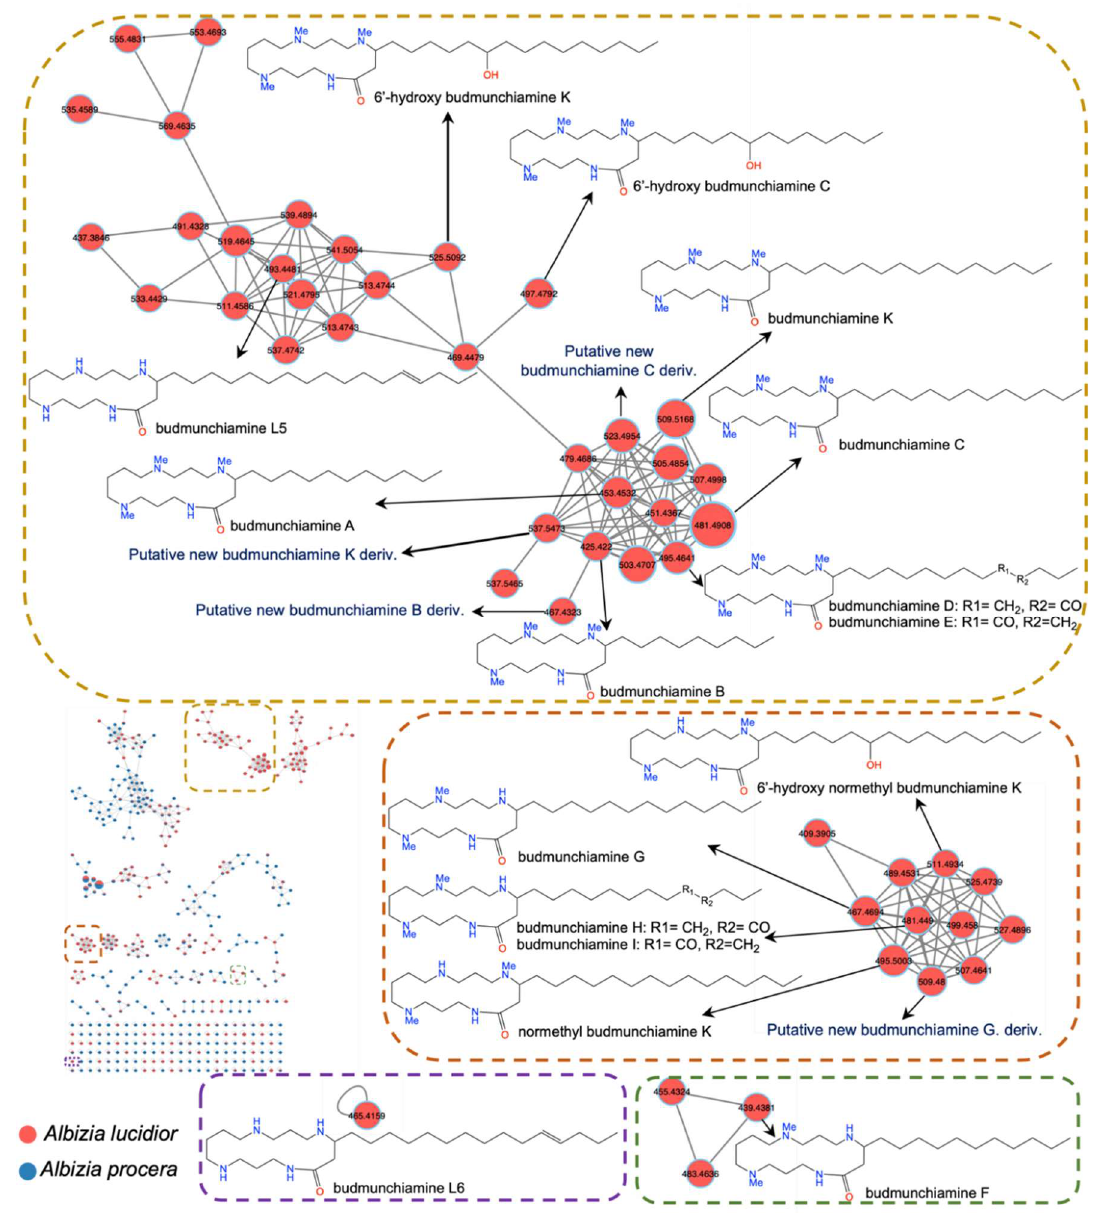
Figure 2. GNPS molecular network of two Albizia spp. ethanolic extracts in the positive ion mode. Each node is displayed as a pie chart representing relative abundance of the metabolite with red and blue colors in the ethanolic extracts of A. lucidior and A. procera , respectively. The node label represents precursor mass ( m / z ). The node size represents the sum of precursor ion intensity.